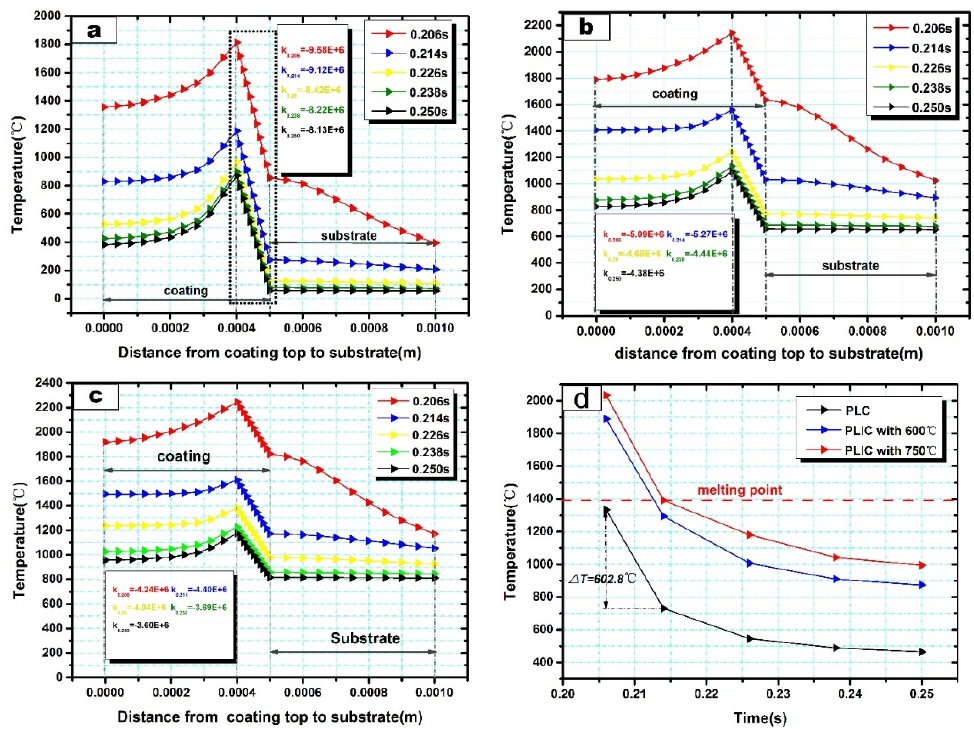
Figure 6. Thickness-direction temperature evolution during the fifth laser pulse interval in ( a ) PLC and PLIC at ( b ) 600 ◦ C and ( c ) 750 ◦ C, ( d ) the temperature–time curve at 0.206–0.250 s at a point with position of y = 0.00045 in the thickness